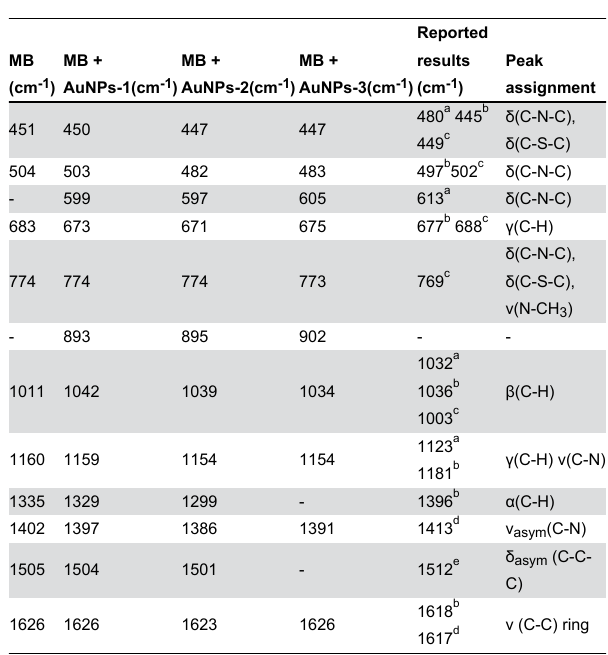
Table 1. Vibrational modes of MB corresponding to its Raman spectrum.